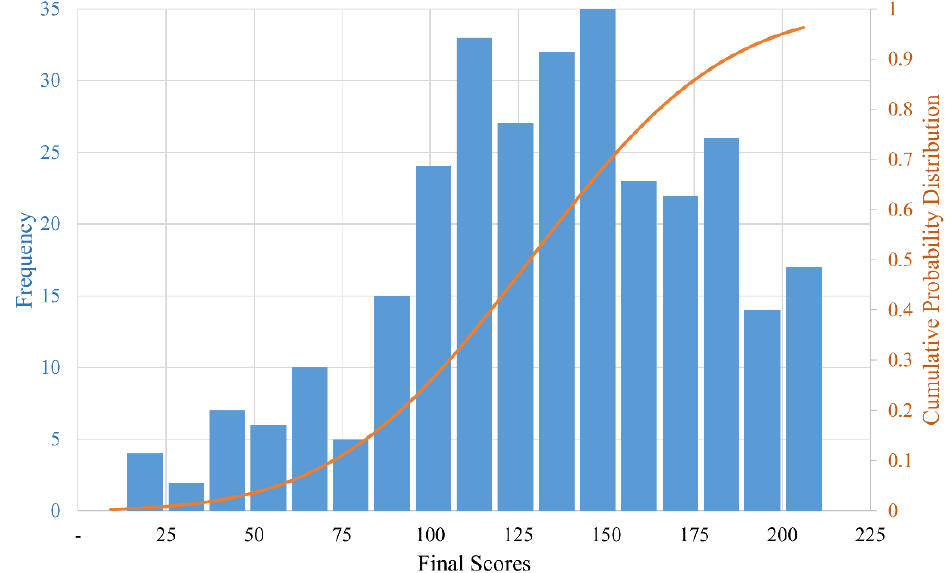
Figure 5. Histogram and cumulative probability distribution function of final scores.